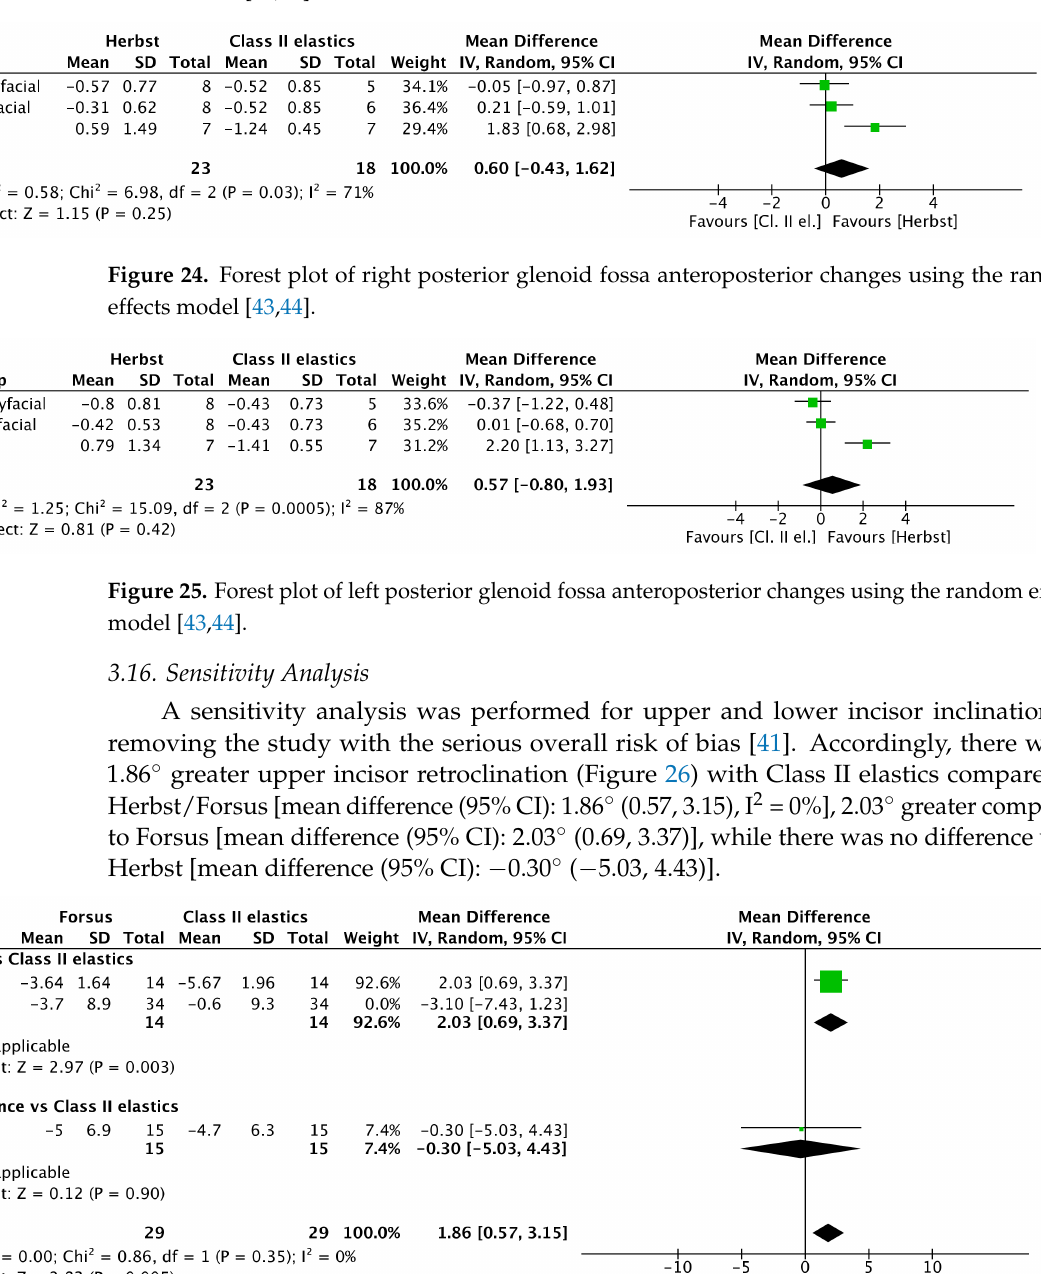
Figure 23. Forest plot of the left anterior glenoid fossa anteroposterior changes using the random effects model [43,44].